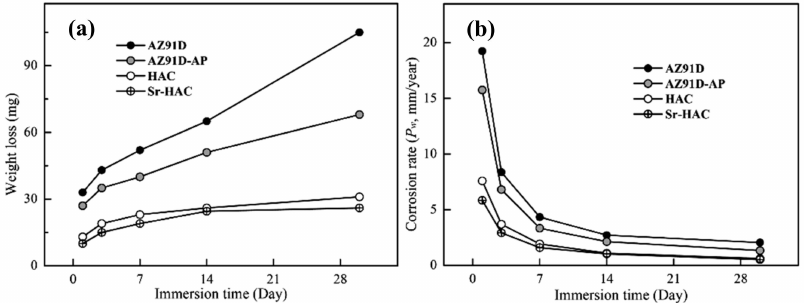
Figure 11. ( a ) Weight loss and ( b ) corrosion rate of the AZ91D, AZ91D-AP, HAC and Sr-HAC specimens evaluated after in vitro immersion tests in the SBF at 37 ◦ C for 1, 3, 7, 14 and 30